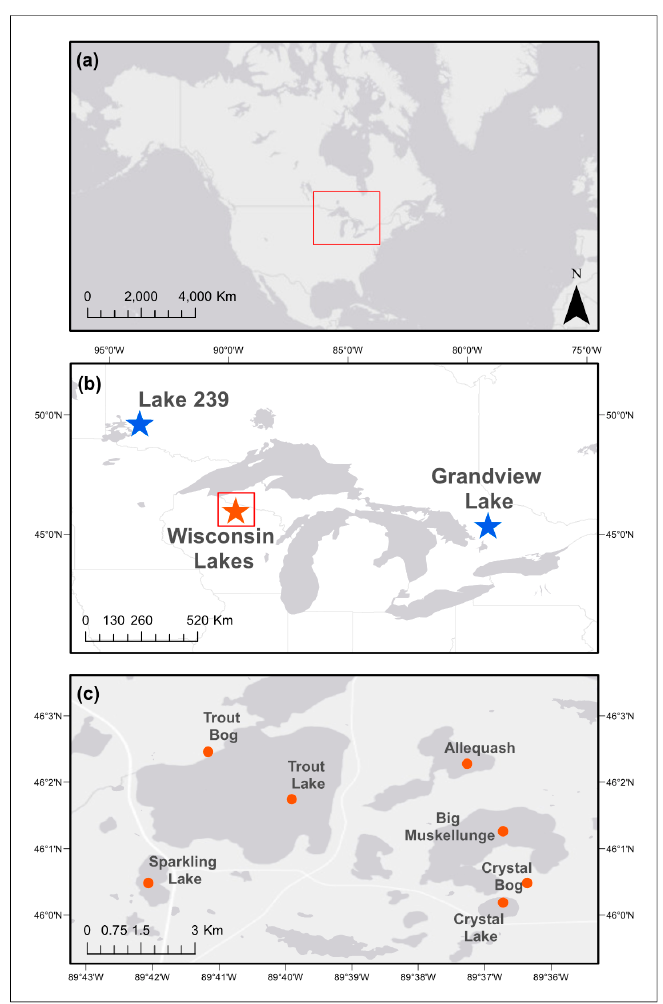
Figure 1. Maps of ( a ) North America (the red box indicates the location of the study regions); ( b ) the study regions in Ontario, Canada (blue stars) and Wisconsin, USA (orange star); and ( c ) a close up of the seven study lakes in northern Wisconsin.